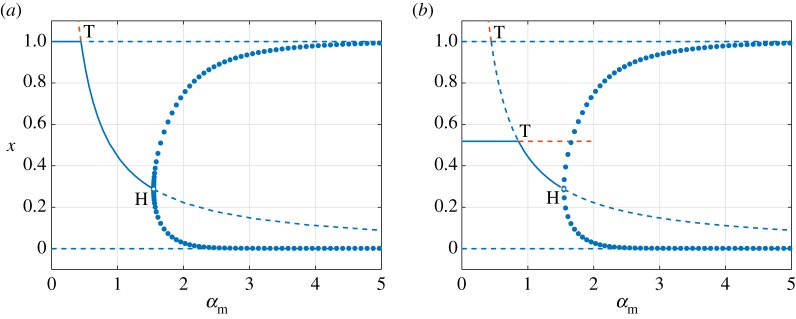
One-dimensional bifurcation diagrams showing the dependence of the equilibrium population of healthy cells x on the infection rate of mutant-type virus αm. We set (a) αw = 0.5 and R0w=0.48 and (b) αw = 2 and R0w=1.93. Solid and dashed curves illustrate, respectively, stable and unstable equilibria. Filled markers stand for maxima and minima of a stable periodic orbit (PO). The letters T and H denote points of transcritical and Hopf bifurcations of equilibria, respectively. Blue denotes biologically relevant solutions (positive variables) while orange describes solutions with negative components. The minimum values of the POs are above zero as αm is increased after the Hopf bifurcation. All the other parameter values are given in (3.12).